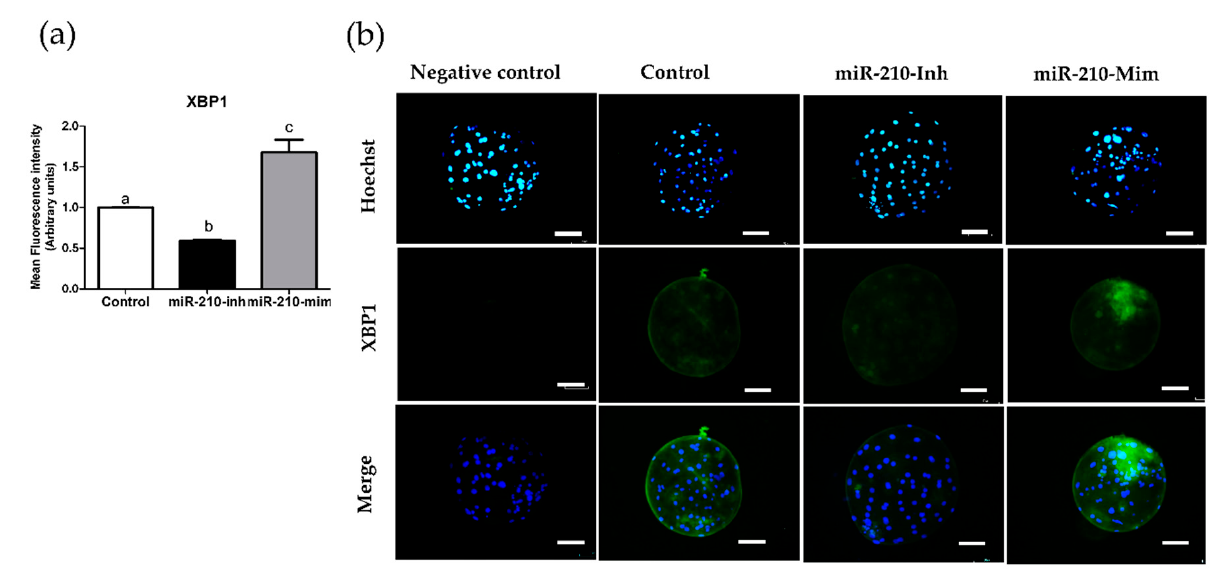
Figure 2. Expression levels of XBP1 , shown as fluorescence intensity in blastocysts of microinjected embryos. ( a ) Chart showing the assessment of fluorescence intensity of XBP1 . At least 20 embryos per group from four biological replicates were analyzed. Data are presented as mean ± SEM. Treatment groups pointed out with letters are considered to be statistically significant ( p < 0.05). ( b ) Images showing immunofluorescence staining of blastocysts (green) in the control, miR- 210-inhibitor, and miR-210-mimic treatment groups. Hoechst staining was used to stain DNA (blue), and merged images were created to demonstrate colocalization (scale bars 50 µ m; 400 × magnification). miR-210-Inh, micro-RNA-inhibitor; miR-210-Mim, micro-RNA-mimic; SEM, standard error of mean.